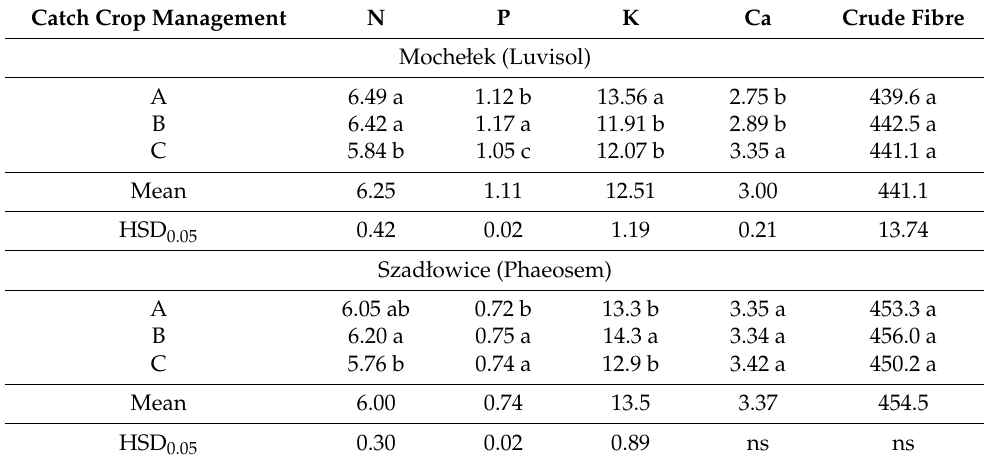
Table 11. Content of macroelements and crude fiber in spring barley straw (g kg − 1 ) depending on a catch crop—means for 2009 to 2011.